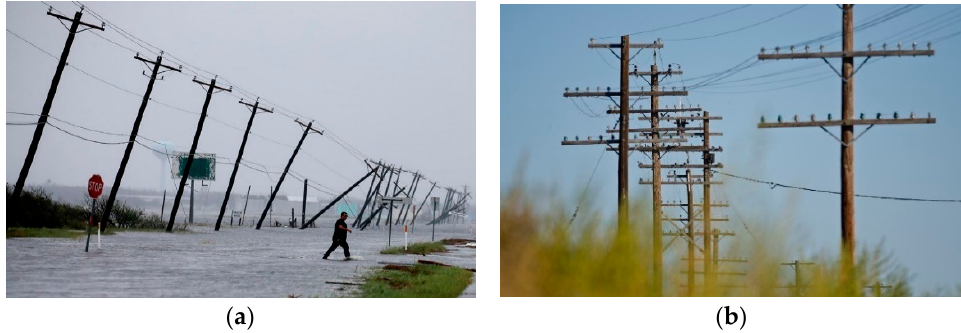
Figure 7. ( a ) Electric pole falls due to floods [61]. ( b ) Wooden electric pole [62].